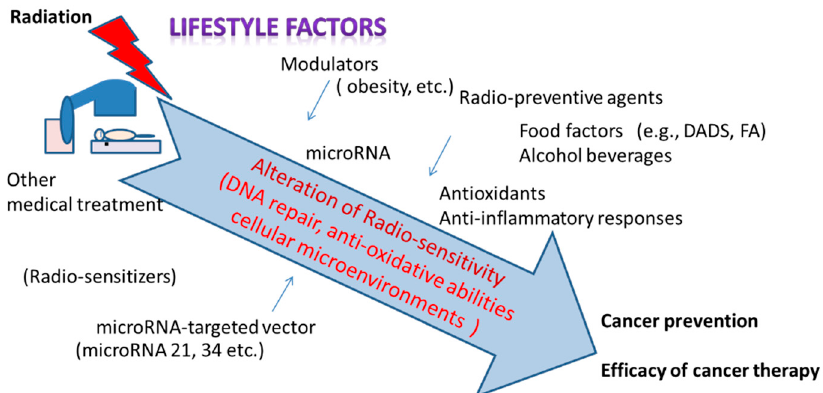
Figure 2. Radio ‐ sensitivity and related factors in radiation protection and cancer radiotherapy. Figure 2. Radio-sensitivity and related factors in radiation protection and cancer